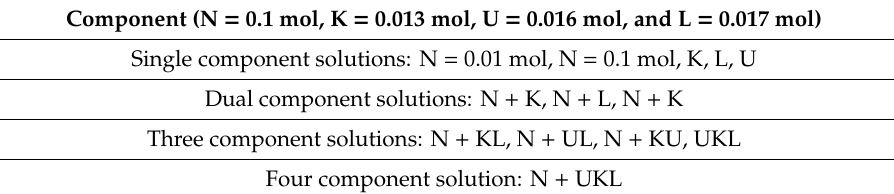
Figure 11. Measured complex permittivity: ( a ) real part ( ε ’) and ( b ) imaginary part at 2.45 GHz Figure 6. (N = 0.1 mol, K = 0.013 mol, L = 0.017 mol, and U = 0.016 mol). Table 5. Component solutions under test (synthesized by dissolving in 1 L of distilled